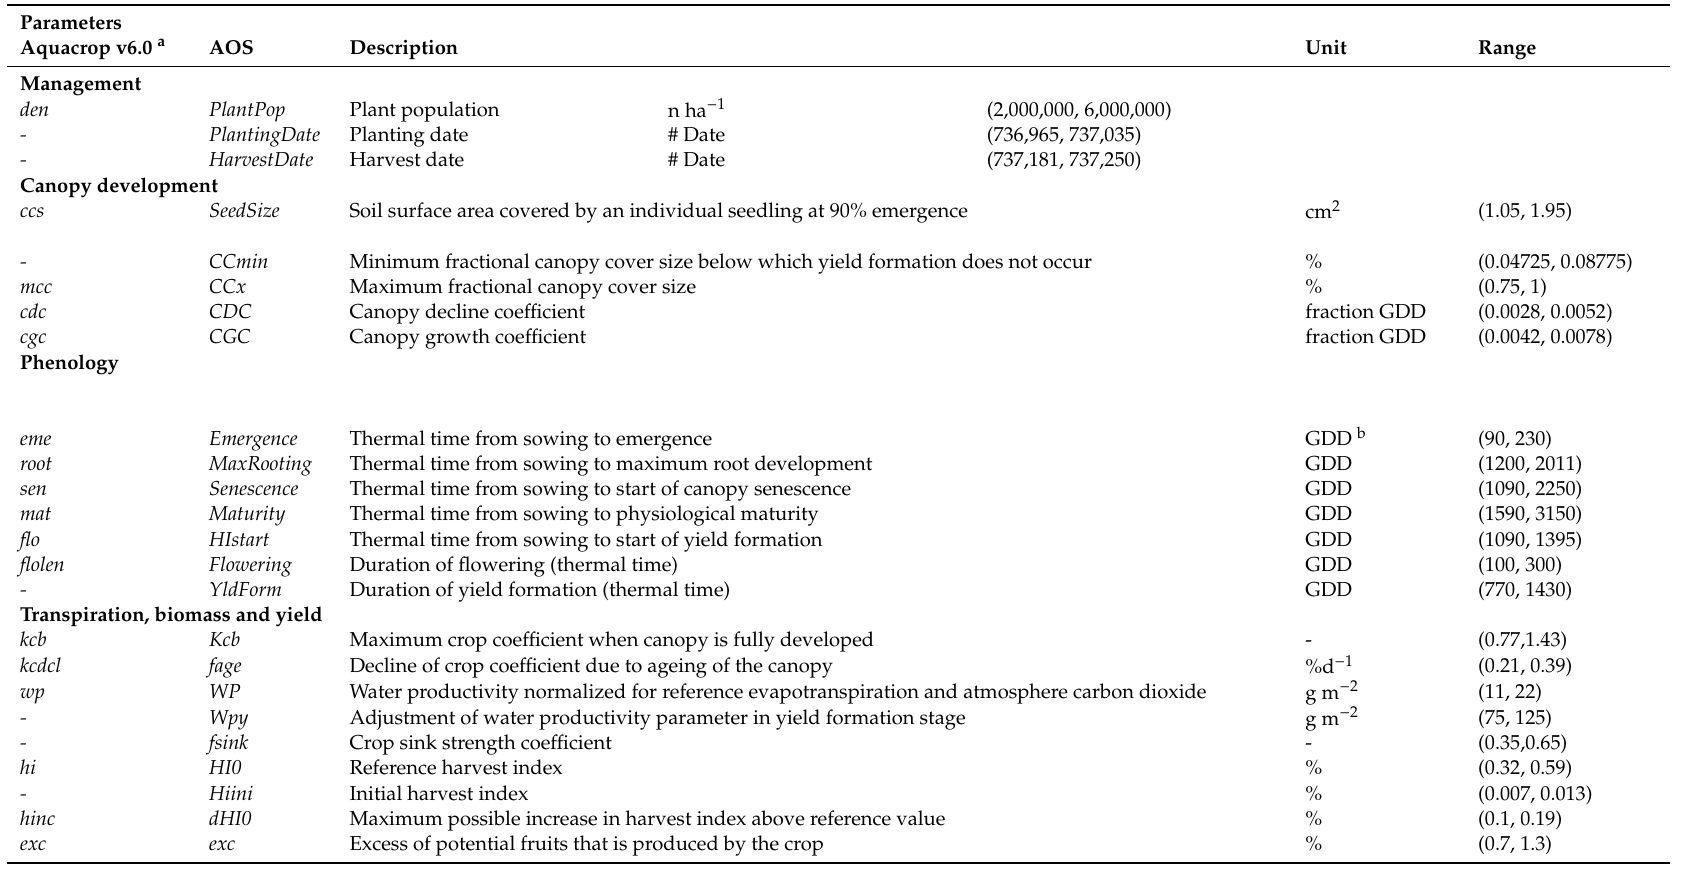
Table 1. AOS parameters considered for sensitivity analysis with the range of values adopted in the present